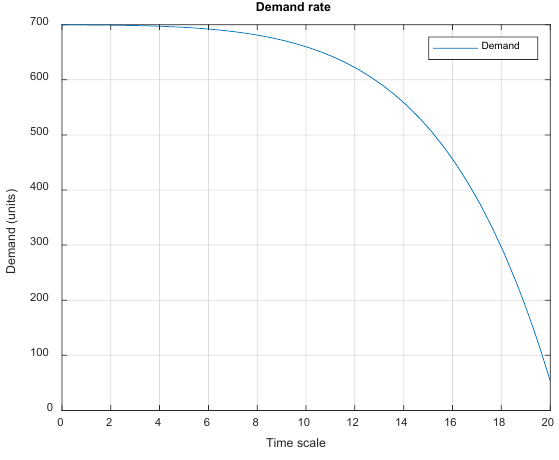
Figure 6. Demand rate. Figure 6. Demand